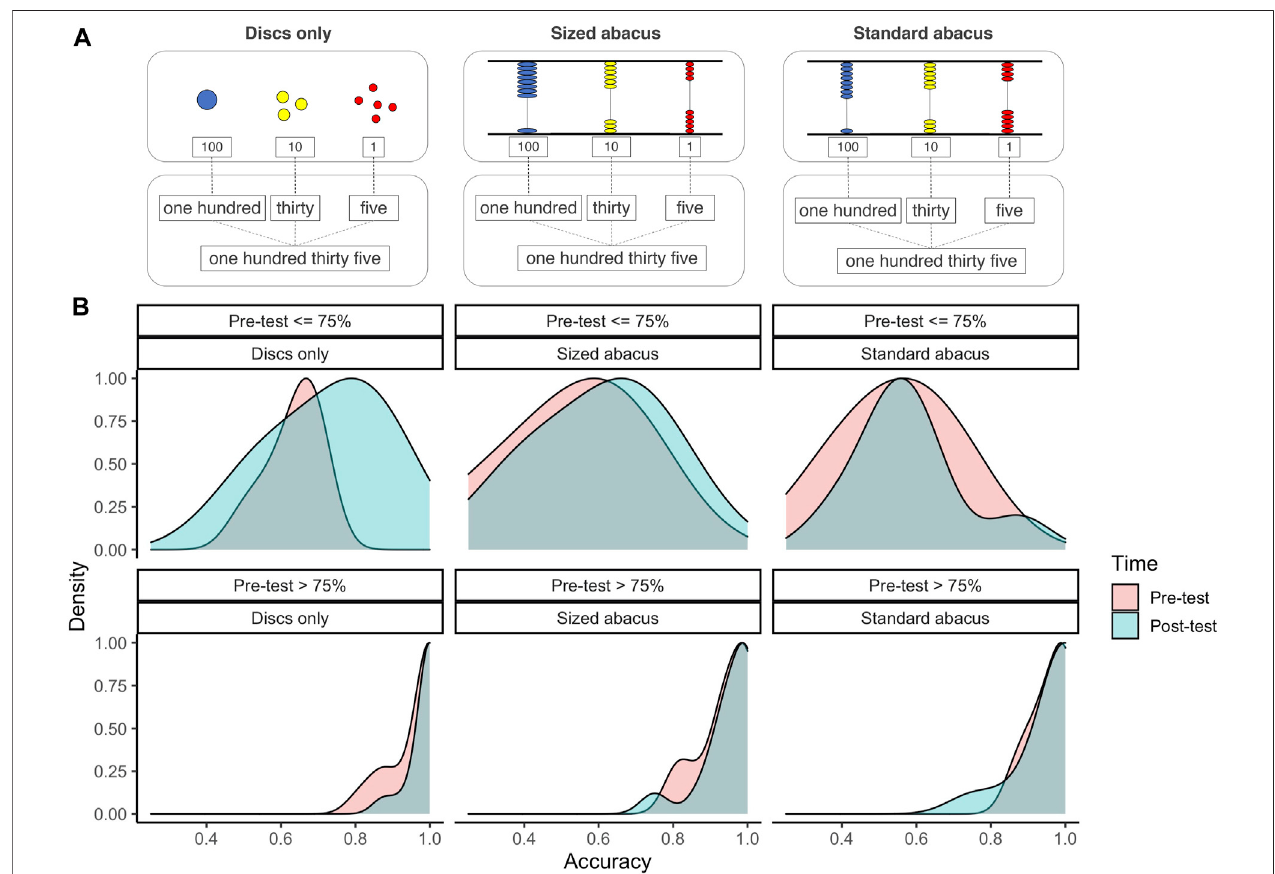
FIGURE 5 | (A) : Illustrations for the three mapping conditions in Experiment 3. (B) : Density graphs ofparticipants ’ accuracy in Experiment 3 by condition, test time (pre-and post-test), andpre-testfamiliaritywithmulti-digitnumbersymbols.In (B)toprow: children who scoredlessthan orequal75%at pre-test.In (B) bottom row: children who scored above 75% at pre-test. Pink indicates pre-test performance and turquoise indicates post-test